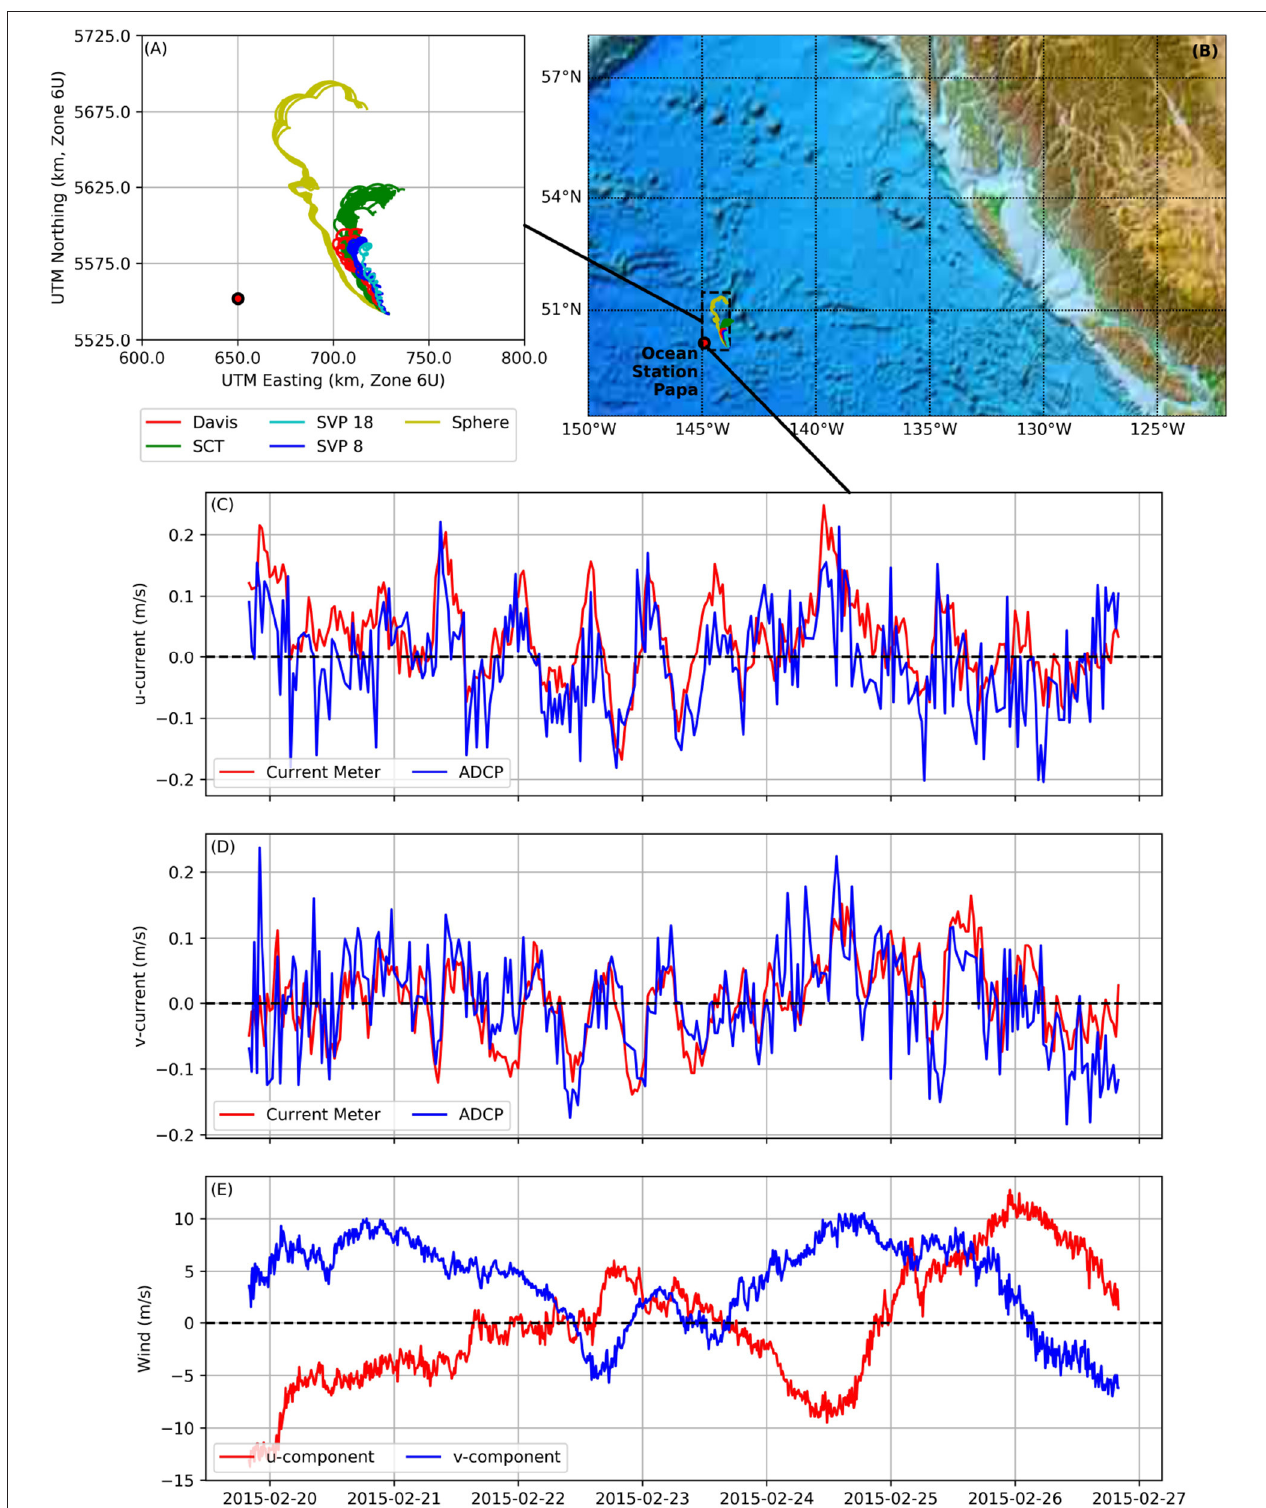
FIGURE 4 | Tracks of drifters for 7 days after deployment near Ocean Station Papa (A,B) , and time series of u,v components of currents (C,D) and wind (E) during the deployment.